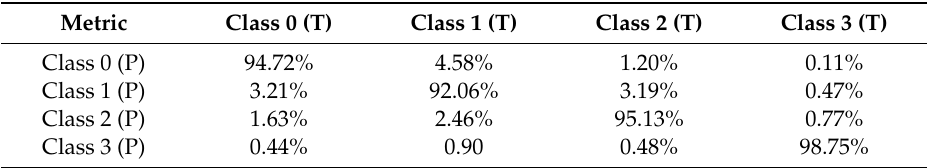
Table 3. The confusion matrix.